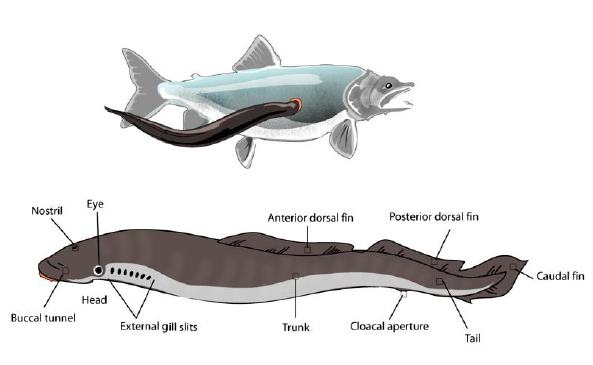
Figure 1: Diagram showing the external morphology of sea lamprey (lower panel) and its parasitic attachment to sea fish (upper panel). (Source of diagram Wikipedia - available under creative